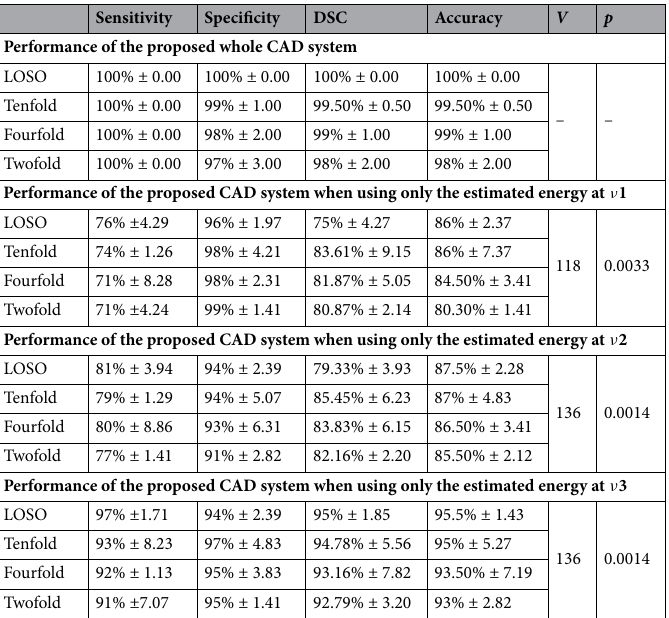
Table 1. Diagnostic accuracy of the proposed CAD system. Feature selection had a significant impact on classifier performance with Friedman test χ 2 = 32.7 , 3 d.f., p = 3 × 10 − 7 . V : Wilcoxon signed rank statistic of performance compared to complete system; p : Associated Bonferroni-corrected p